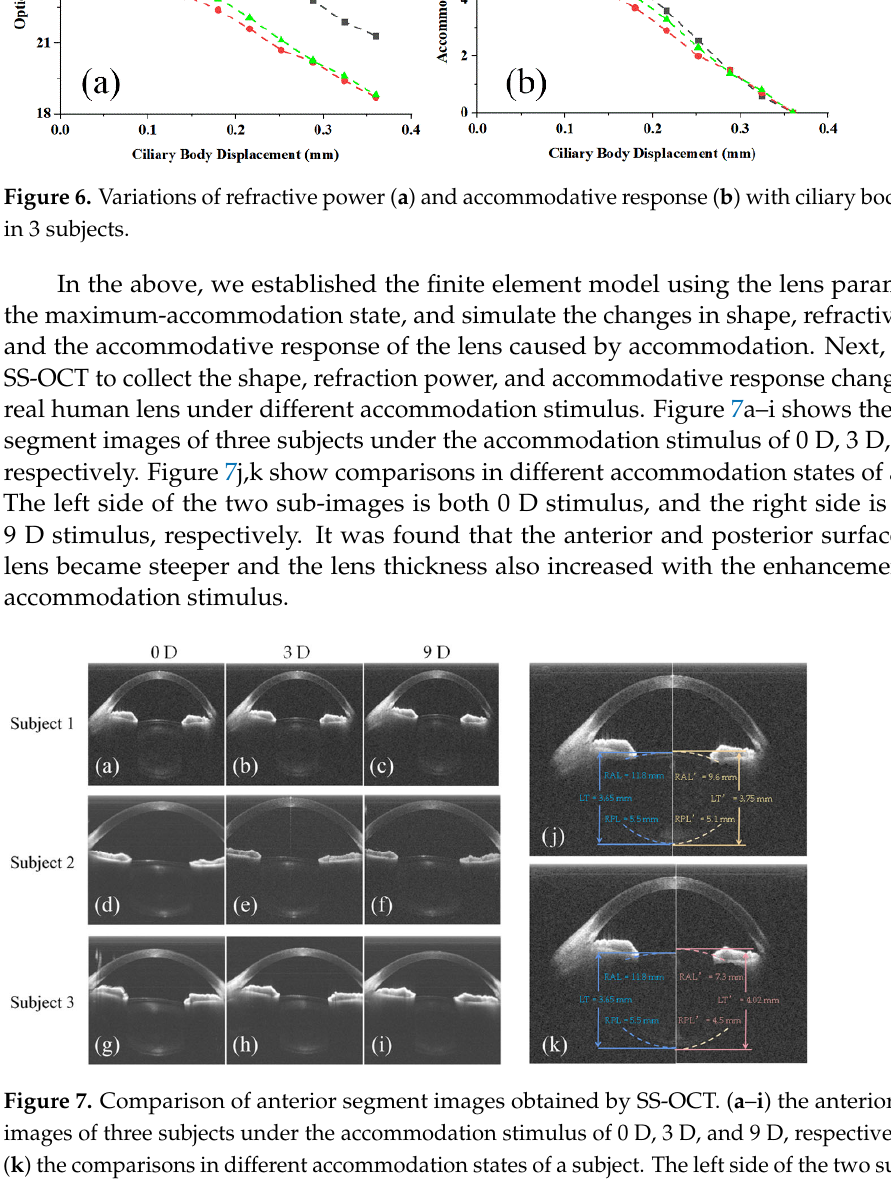
Figure 8. The change of lens geometric parameters during accommodation in 3 subjects: ( a ) anterior lens curvature radius; ( b ) posterior lens curvature radius; ( c ) lens thickness. Figure 9a shows the refractive power of the lens as a function of the accommodative stimulus. The overall refractive power of the lens ranges from 19.5 D to 28.1 D. The